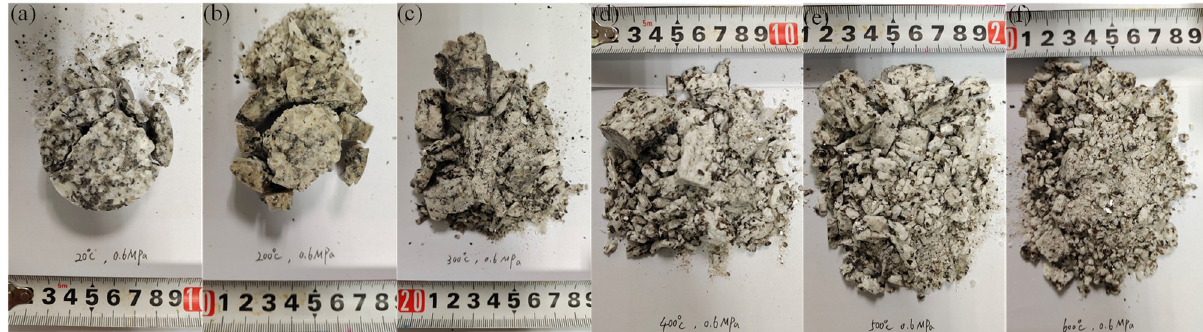
Figure 17. Relationship between fragment degree of specimens and temperature at 0.6 MPa. ( a ) 20 °C, ( b ) 200 °C, ( c ) 300 °C, ( d ) 400 °C, ( e ) 500 °C, ( f ) 600 °C.